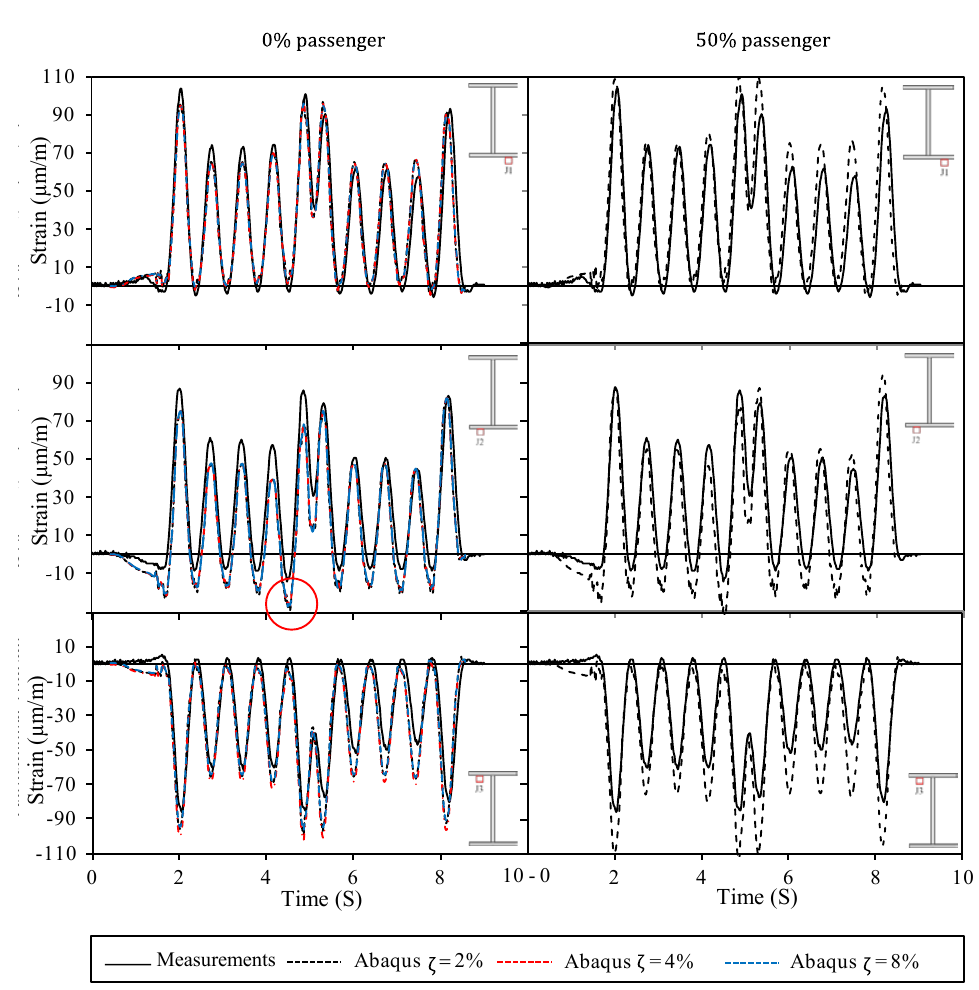
Figure 13. Comparison between measurements and FE results with different damping ratios and passenger occupancy